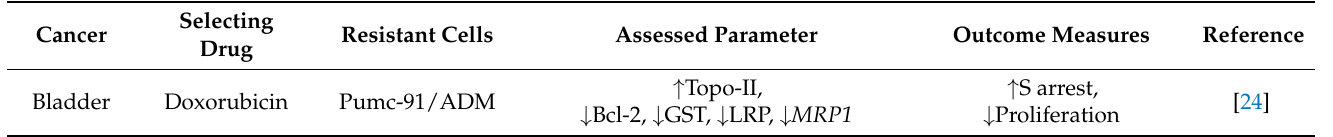
Table 2. Assessed parameters and outcome measures of RES treatment in various drug-resistant cancer